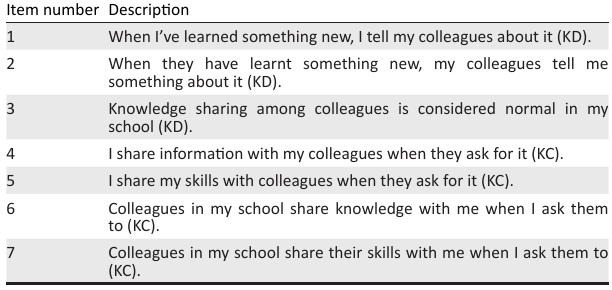
TABLE 1 : Knowledge sharing behaviour